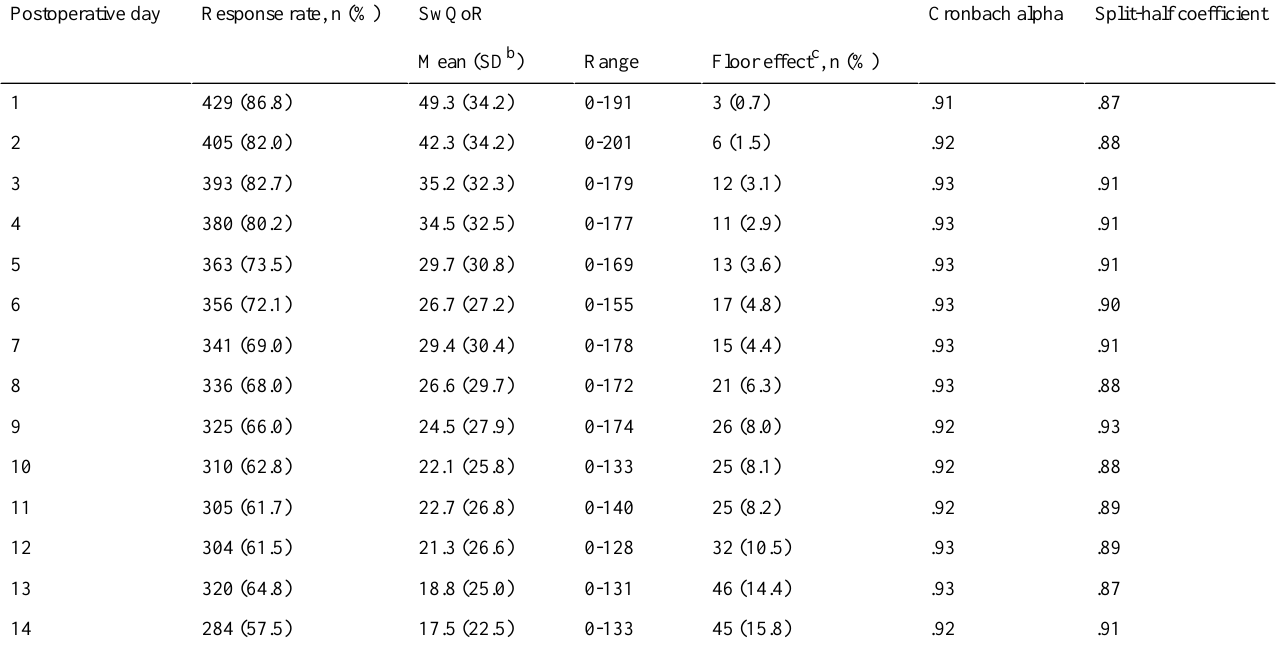
Table 2. SwQoR a response rate, mean and range, floor effect, Cronbach alpha, and split-half coefficient on days 1-14 (n=494).